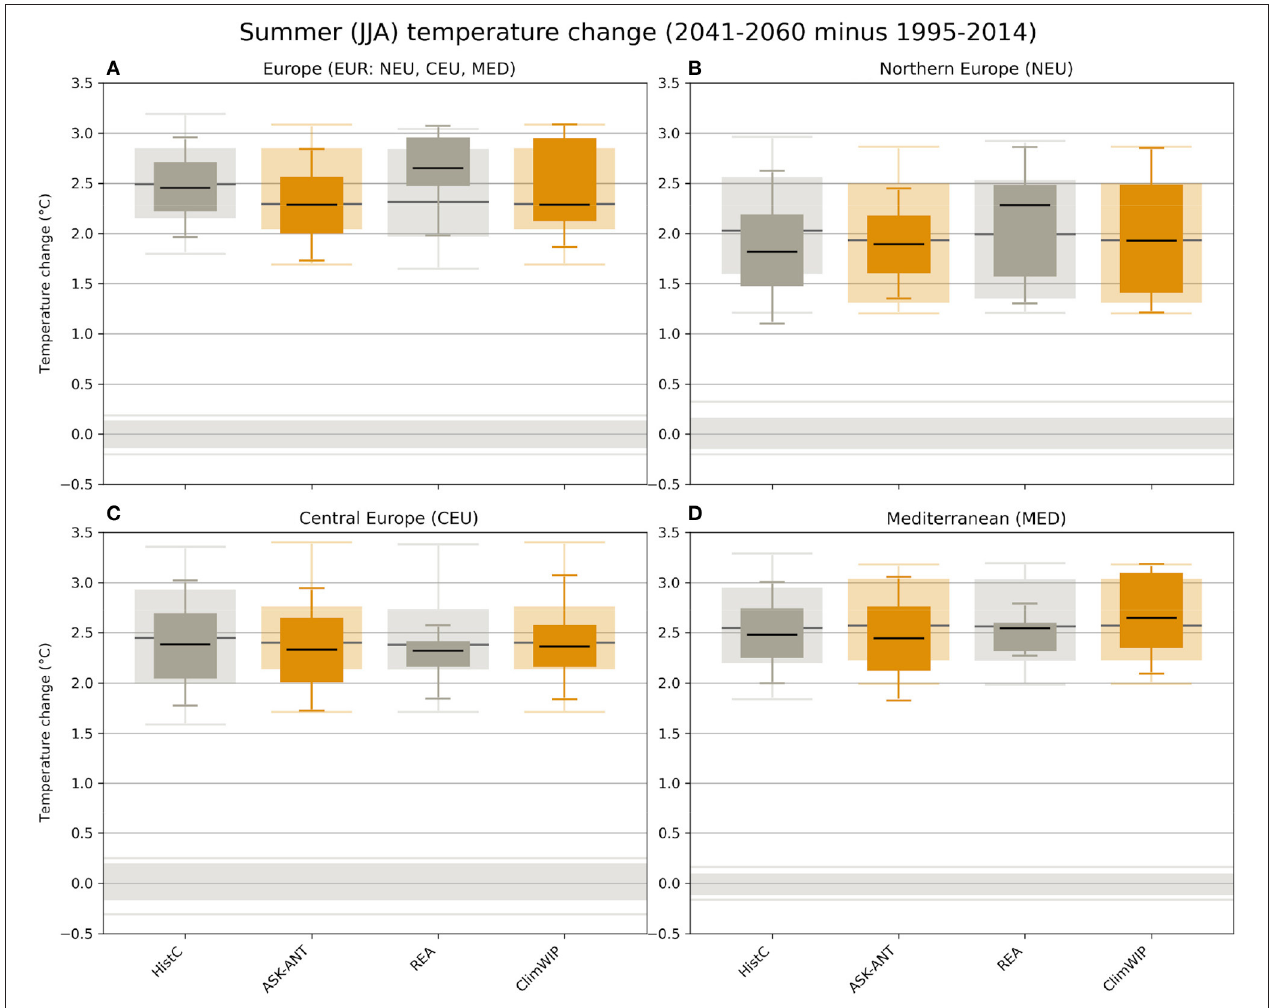
FIGURE 2 | Projected summer (June–August) temperature change 2041–2060 relative to 1995–2014 for (A) the combined European region as well as (B–D) the three European SREX regions (Northern Europe, Central Europe, and the Mediterranean) using RCP8.5. The lighter boxes give the unconstrained distributions originating from model simulations; the darker boxes give the observationally constrained distributions. Shown are median, 50% (bars) and 80% (whiskers) range. The gray box and lines centered around zero show the same percentiles of 20-years internal variability based on observations. Methods ASK-ANT and ClimWIP used in this paper are colored, additional methods HistC and REA shown in Brunner et al. (2020a), but not used in this paper, are in gray. After Figure 6 in Brunner et al.